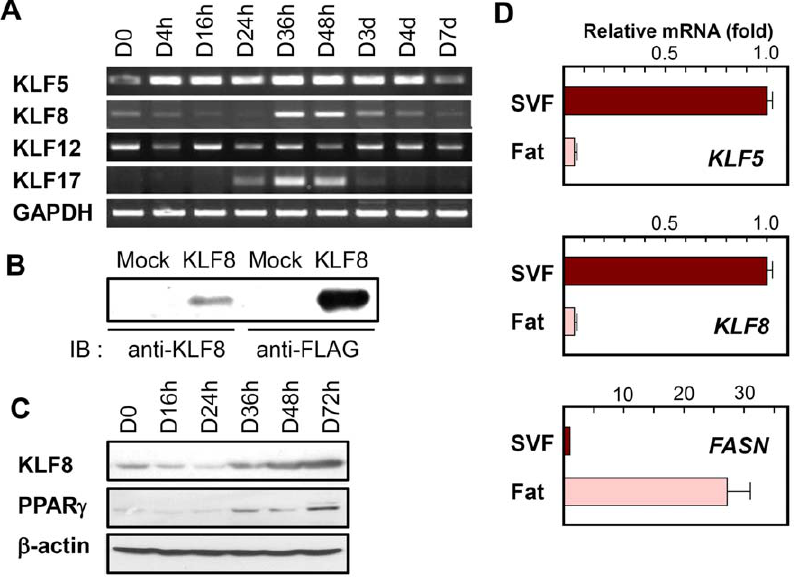
Figure 1. KLF8 expression during 3T3-L1 adipocyte differentiation and in mouse adipose tissue. (A) Total RNA was extracted from 3T3- L1 cells at the indicated times before and after induction of differentiation. The expression levels of KLF5, KLF8, KLF12, and KLF17 were determined by RT-PCR. (B) Anti-rabbit polyclonal KLF8 antibody was generated and tested on 293T cells that were transfected with either pcDNA3.0 or pcDNA3.0- KLF8-FLAG. Whole-cell lysates were immunoblotted (IB) using anti-KLF8 or anti-FLAG, which verified the specific antigen-antibody interaction. (C) Western blot analysis of KLF8 expression was performed at the indicated time points during 3T3-L1 cell differentiation. (D) KLF5, KLF8, and fatty acid synthase (FASN) mRNA levels were measured in the stromal vascular fraction (SVF) or the fat fraction of mouse epididymal adipose tissue using real- time qPCR. Data represent the mean 6 SD.